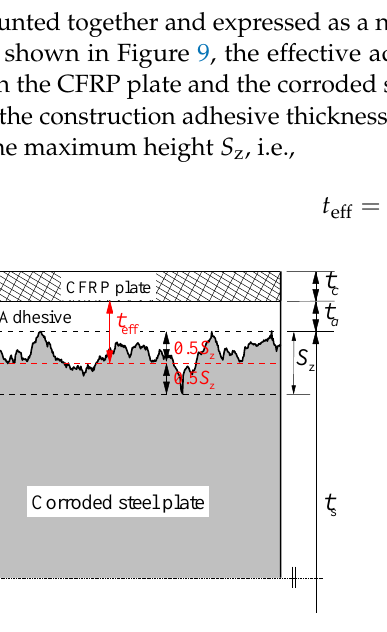
Figure 9. Schematic diagram of the cross-section for the bonding interface between the CFRP plate and the corroded steel plate.